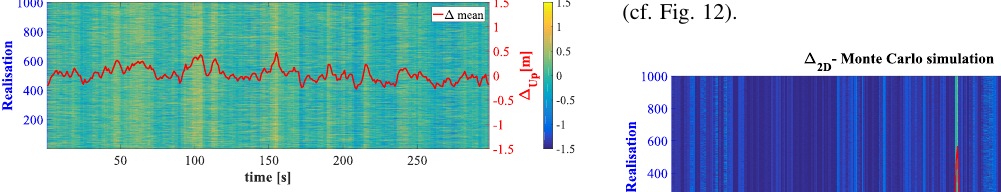
Figure 8. Variations in Up direction. Vehicle 1 - Sensor setup 1